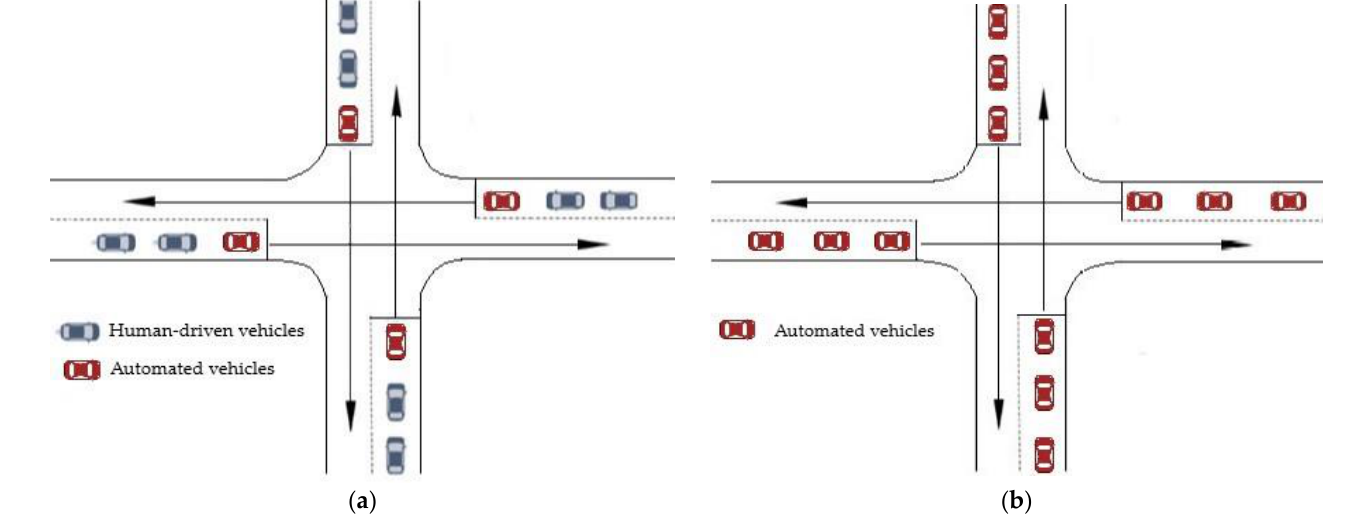
Figure 6. A comparison experiment with go straight movements in the context of a non-signalized intersection: ( a ) mixed-traffic conditions with market penetration rates ranging from 20% to 80%; ( b ) fully autonomous conditions with a 100% market penetration rate.